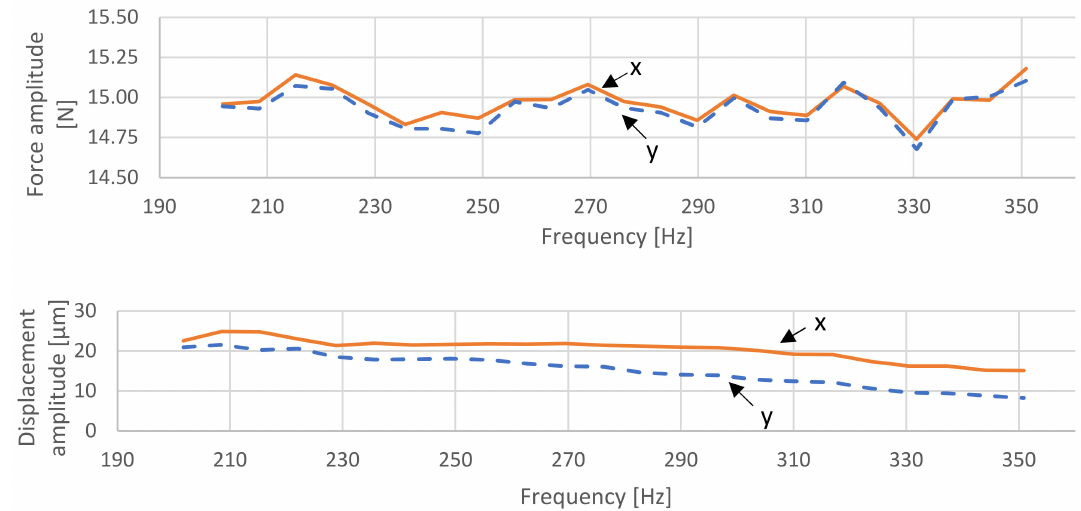
Figure 12. Main force amplitude ( top ) and displacement amplitude ( bottom ) of measured sensor data of pre-tests with 11.1 N static load and 15 N force amplitude (only synchronous).